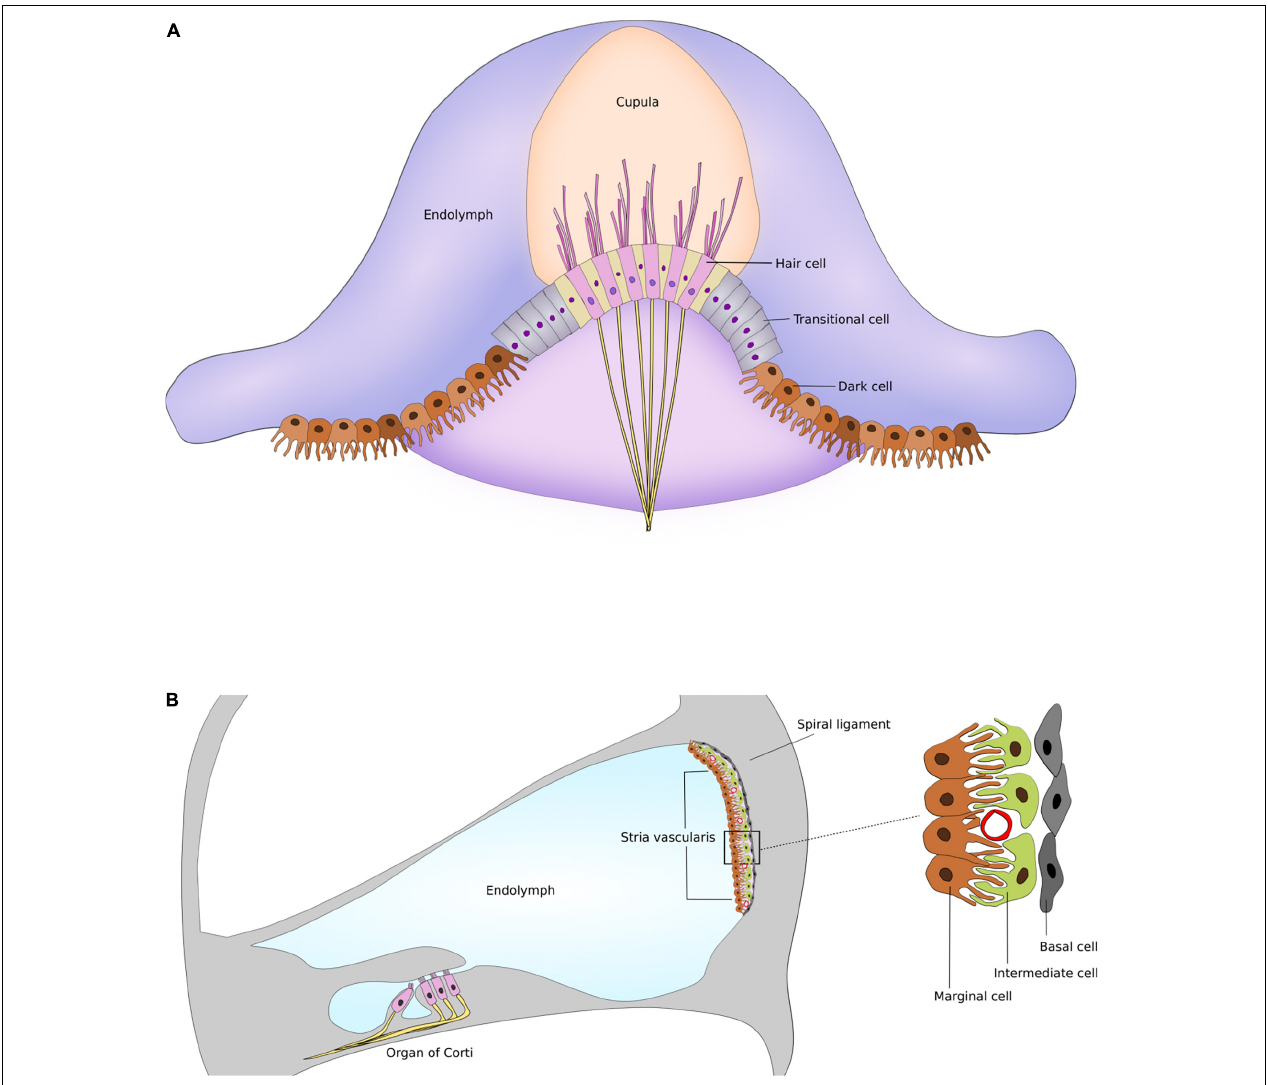
FIGURE 1 | Supporting cells and structures of the inner ear. (A) Schematic drawing of dark cells and transitional cells in the semicircular canal. (B) Schematic drawing of stria vascularis within the cochlea illustrating the marginal, intermediate and basal cell layers. Figures are not drawn to